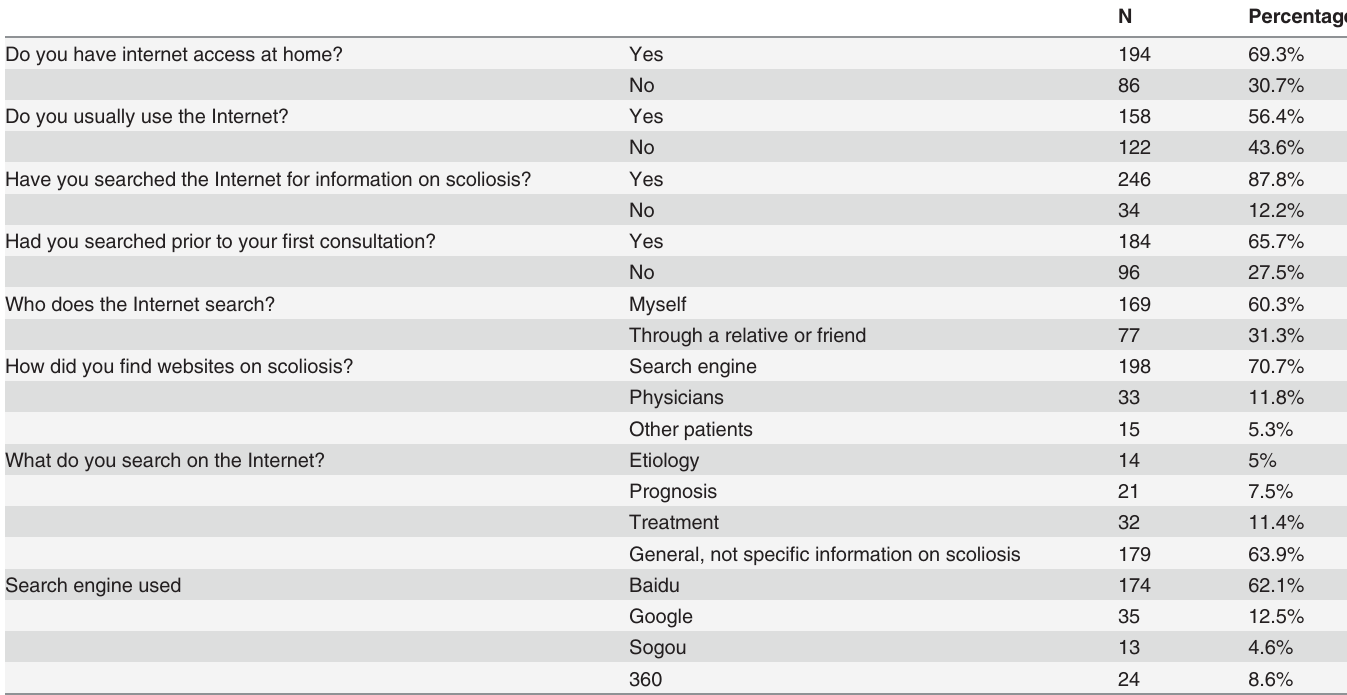
Table 2. Results of assessment of the general Internet usage of the respondents.